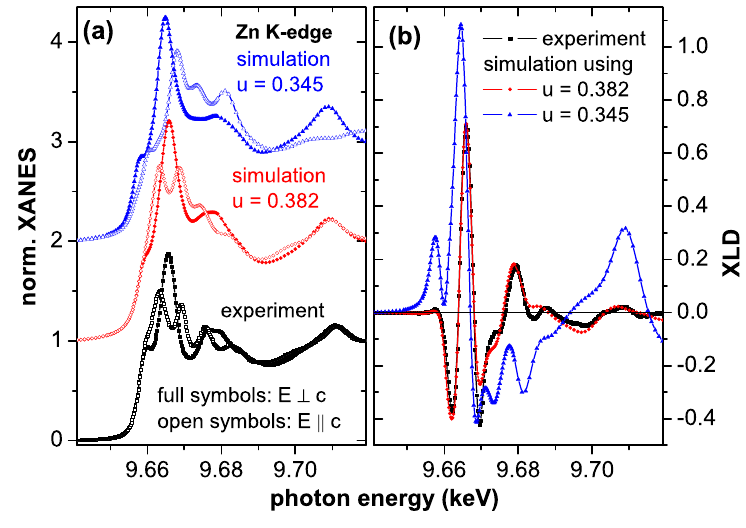
Figure 3. (a) XANES spectra recorded at the Zn K -edge with E ∥ c (open symbols) and E ⊥ c (full symbols) and corresponding XLD (b). The experimental data (black) were recorded at 300 K under 10 ◦ grazing incidence. The simulations using the FDMNES code were done using the bulk lattice parameters and two different u -parameters, u = 0 : 382 (red) and u = 0 : 345